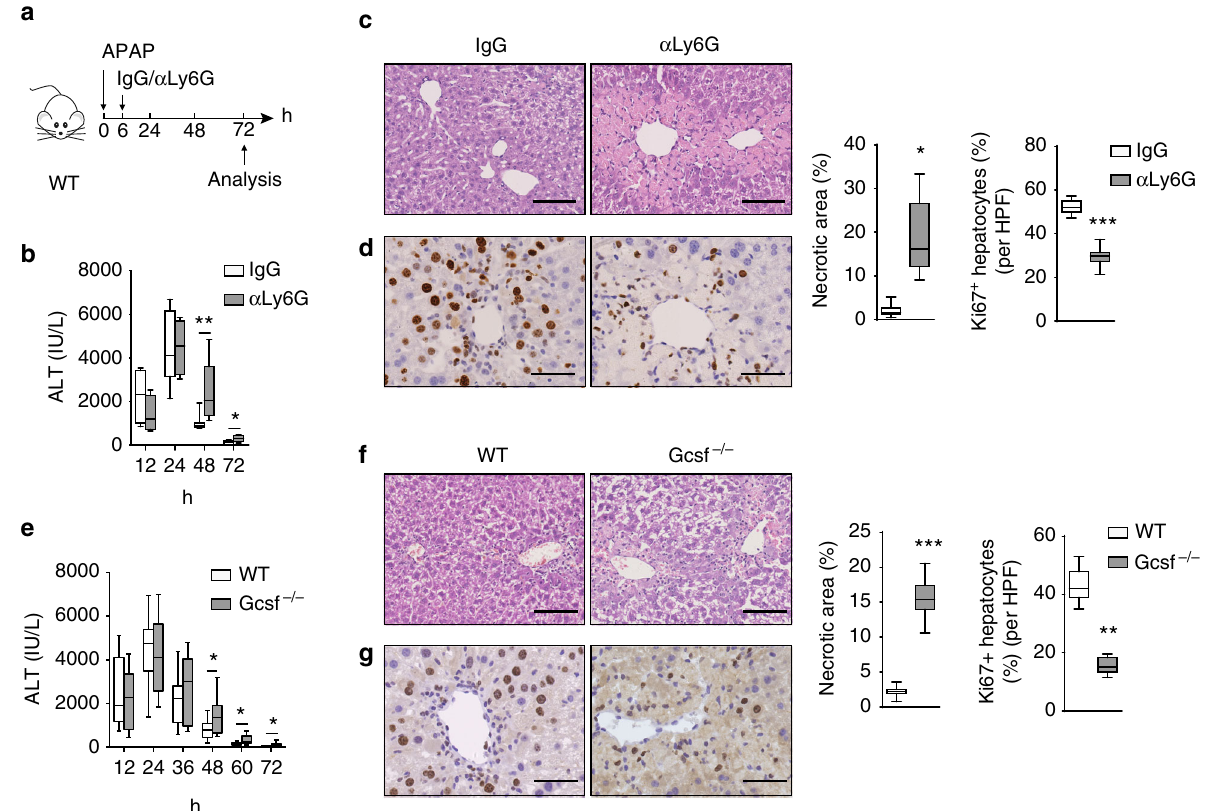
Fig. 1 Neutrophils contribute to liver repair after acute injury. a – d Schematic of the experimental design. a Mice were treated with the neutrophil-depleting anti-Ly6G mAb or an isotype control (IgG) at 6 h after APAP challenge. Serum ALT levels at each time point ( b ), histological characterization ( c ), and IHC staining for Ki67 ( d ) in liver sections at 72 h were evaluated. Percentage of necrotic areas and Ki67 positive hepatocytes per high-powered fi eld (HPF) were also quanti fi ed. n = 5. Experiment was repeated three times. e – g WT and Gcsf − / − mice were challenged with APAP. Serum ALT levels at each time point ( e ), histological characterization ( f ), and IHC staining for Ki67 ( g ) in liver sections at 72 h are shown. n = 13, 12. The data are pooled from two independent experiments. The bar graph indicates 100 μ m ( c , f ), 50 μ m ( d , g ). Whiskers show min to max. Bars show the median (* P < 0.05, ** P < 0.01, *** P < 0.001). P values were calculated by two-tailed Student ’ s t -test ( b – g